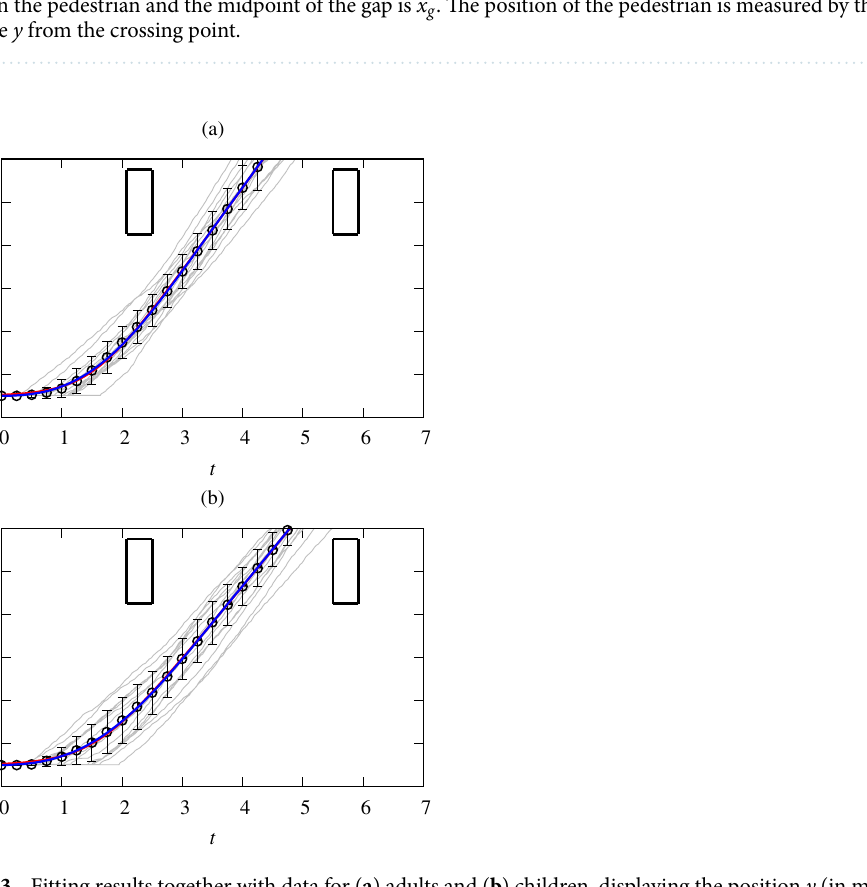
Figure 3. Fitting results together with data for ( a ) adults and ( b ) children, displaying the position y (in meters) versus time t (in seconds). Circles and error bars indicate averages and standard deviations of positions, respectively. Blue and red lines correspond to Eqs. (13) and (17) fitted to the averaged data, respectively. The blue and red lines overlap significantly. Individual time series data are plotted in grey and rectangles represent